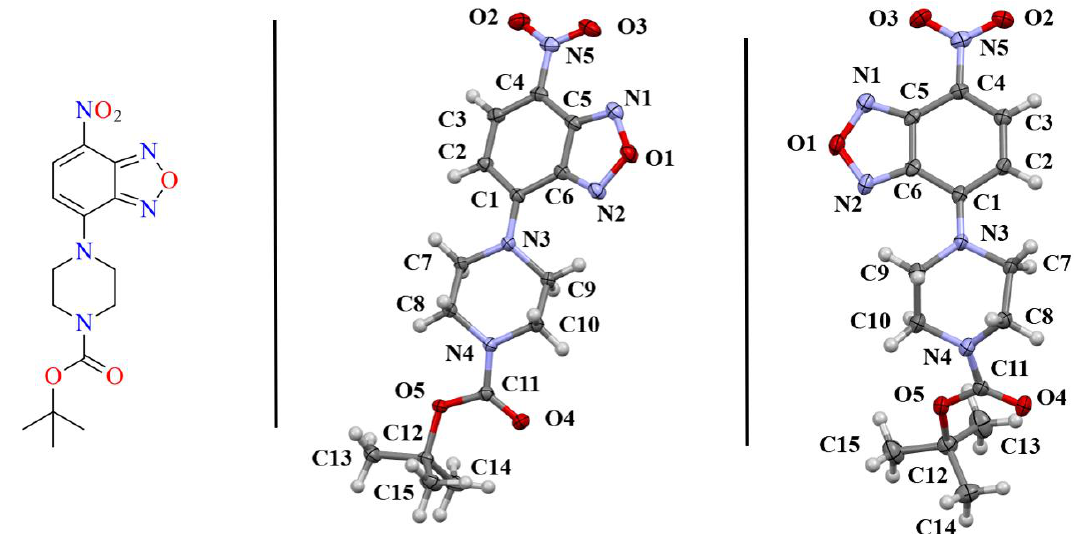
Figure 1. ( left ) Sketch of the benzoxadiazole compounds examined herein. The asymmetric unit of the monoclinic polymorph 1-M ( middle ) and orthorhombic polymorph 1-O ( right ) are shown with 50% probability ellipsoids. The naming scheme for the crystals is shown. Coloring of atoms is by element, as depicted in the sketch. Compound 1 crystallized in both a monoclinic 𝑃2 1 /𝑐 ( 1-M ) and orthorhombic 𝑃𝑐𝑎2 1 ( 1-O ) crystal system. Both crystal structures had one molecule in the asymmetric